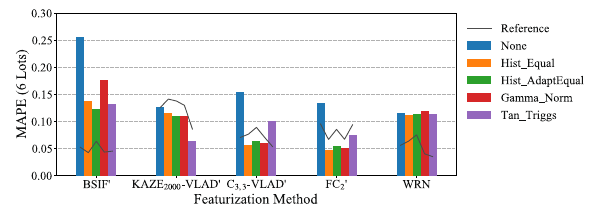
Fig. 9 Average performances of the ML models, trained on original datasets, and evaluated on the new dataset. References refer to average performances of the same six lots in the original data. Prime superscript denotes that the model was trained on the 6000-image reduced dataset. No prime superscript means the model was trained on the full